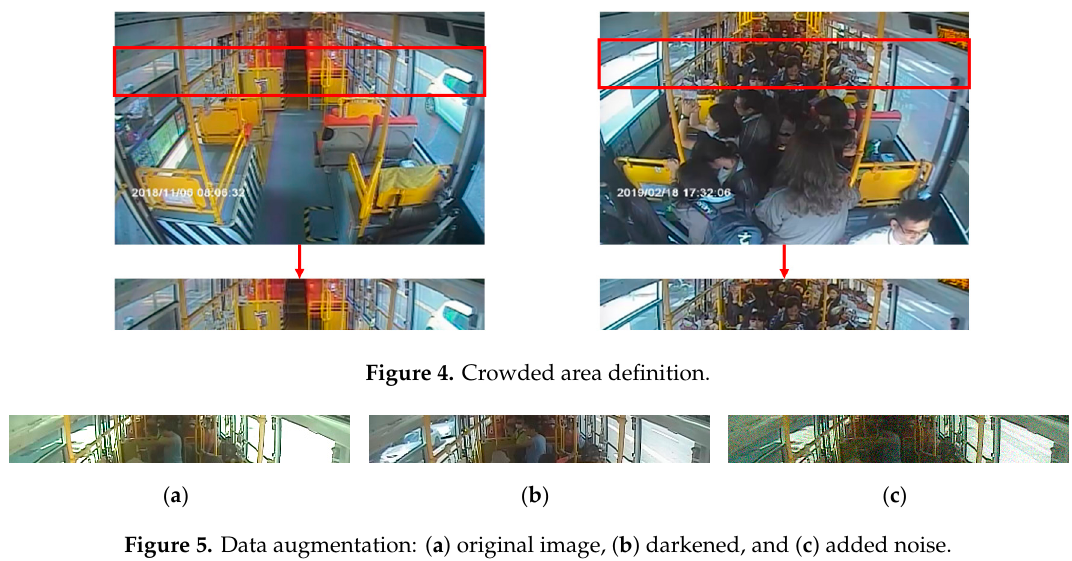
Figure 3. Examples of in-vehicle images obtained from each surveillance camera: ( a ) daytime scene, ( b ) nighttime interior lighting scene, ( c ) scenes a ff ected by light.